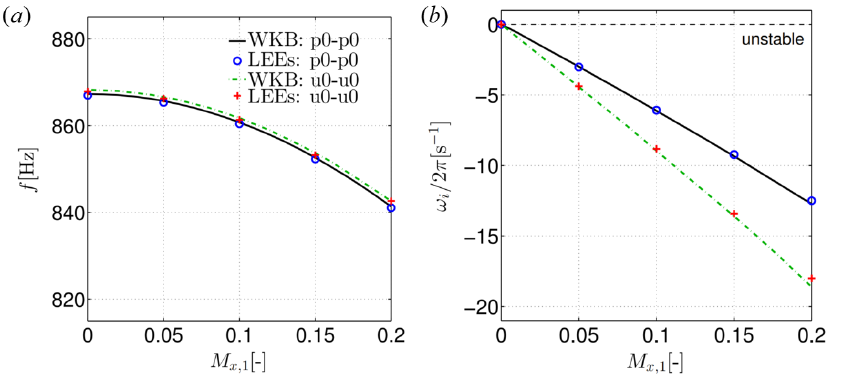
Figure 5. Variation of the first transverse (1T) mode with the incoming flow Mach number for the open–open ends and the closed–closed ends: ( a ) resonant frequencies and ( b ) growth rates. ¯ T = 1600 K, ¯ T = 1200 2 1